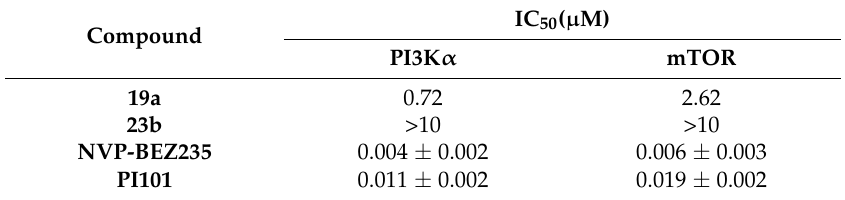
Table 2. Enzymatic activities of compounds 19a and 23b against PI3K α and mTOR (IC 50 , µ M).